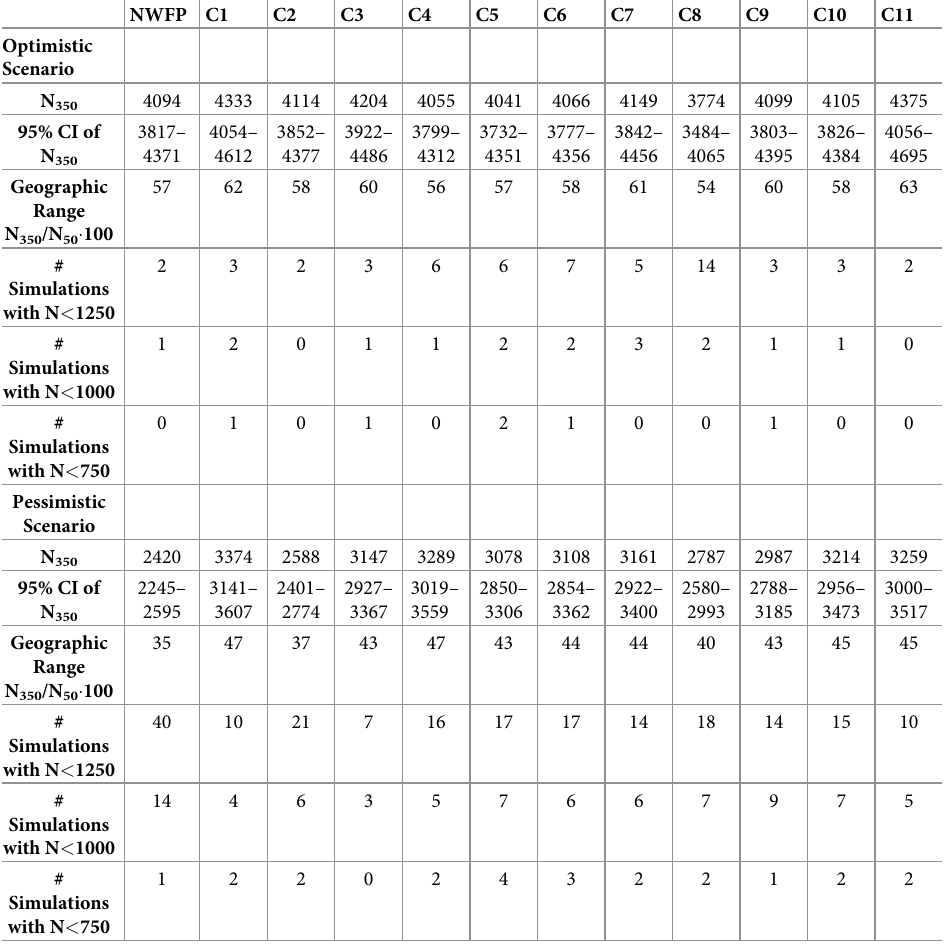
Table 13. Estimated range-wide northern spotted owl population responses to candidate critical habitat networks for the optimistic and pessimistic relative habitat suitability change